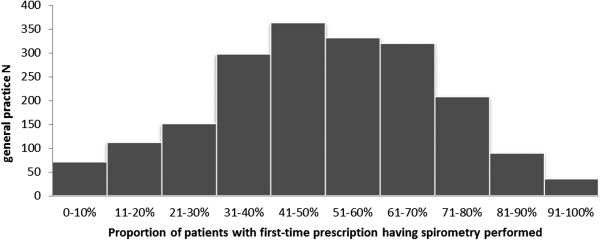
Distribution of the spirometry proportion among general practice in total numbers (N=1980).